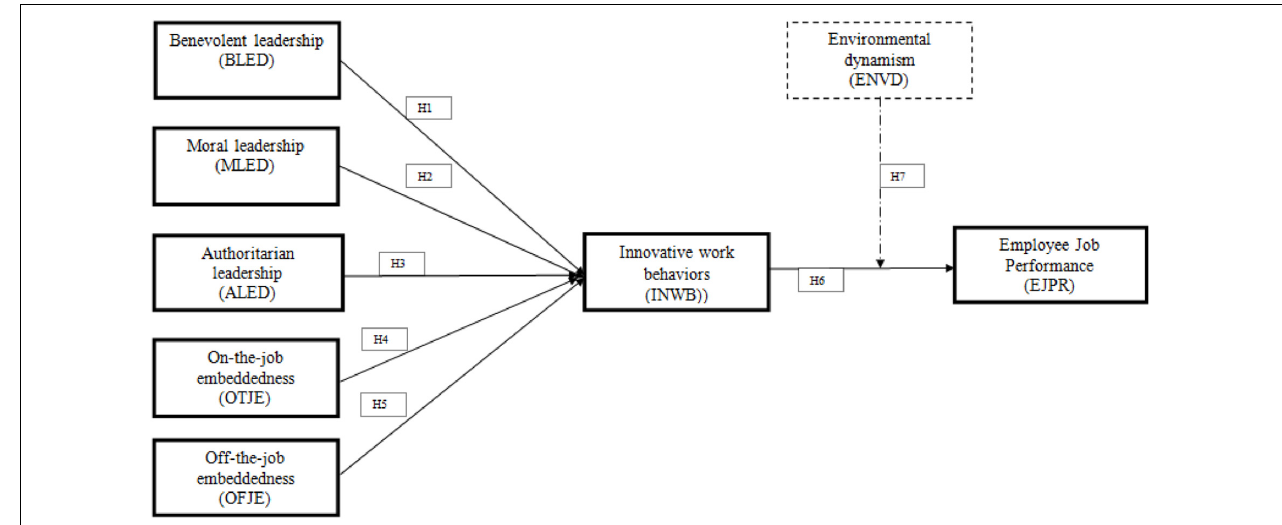
FIGURE 1 | The proposed research